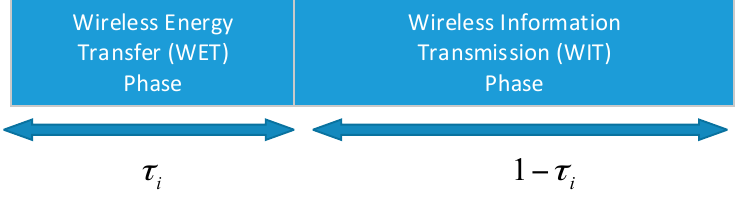
Figure 2. Two-step transmission phase.